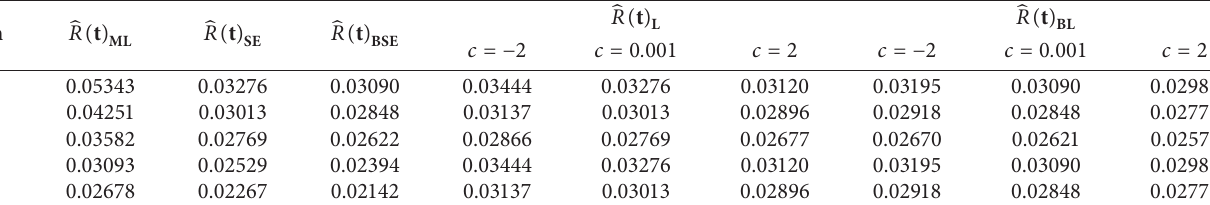
Table 3: Absolute bias of the estimates of R ( t ) at t �